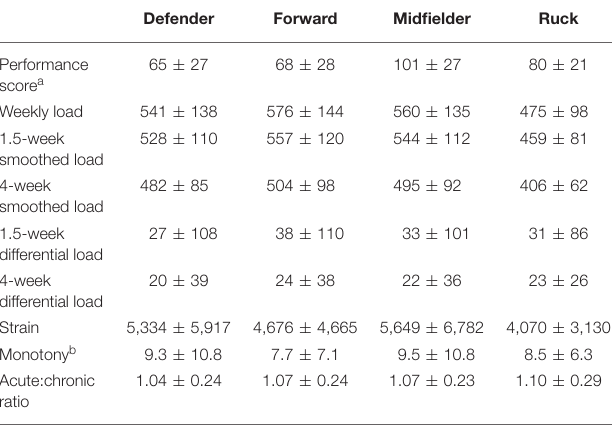
TABLE 2 | Effects of the training measures on performance score derived from the quadratic mixed model. Change in performance score a (mean; ± 90%CL) − 1 SD from the + 1 SD from the Recommendation for mean load mean load